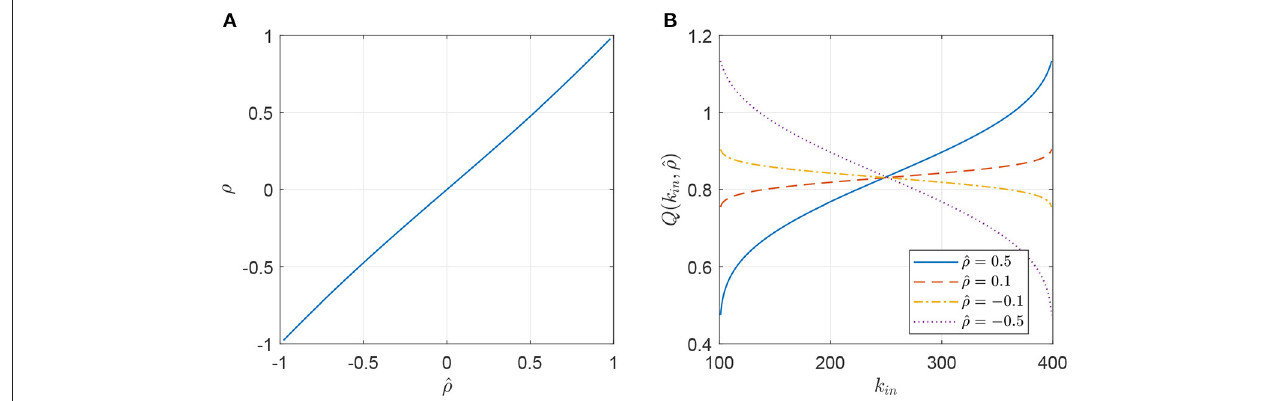
ρ used in the Gaussian copula. (B) The ˆ